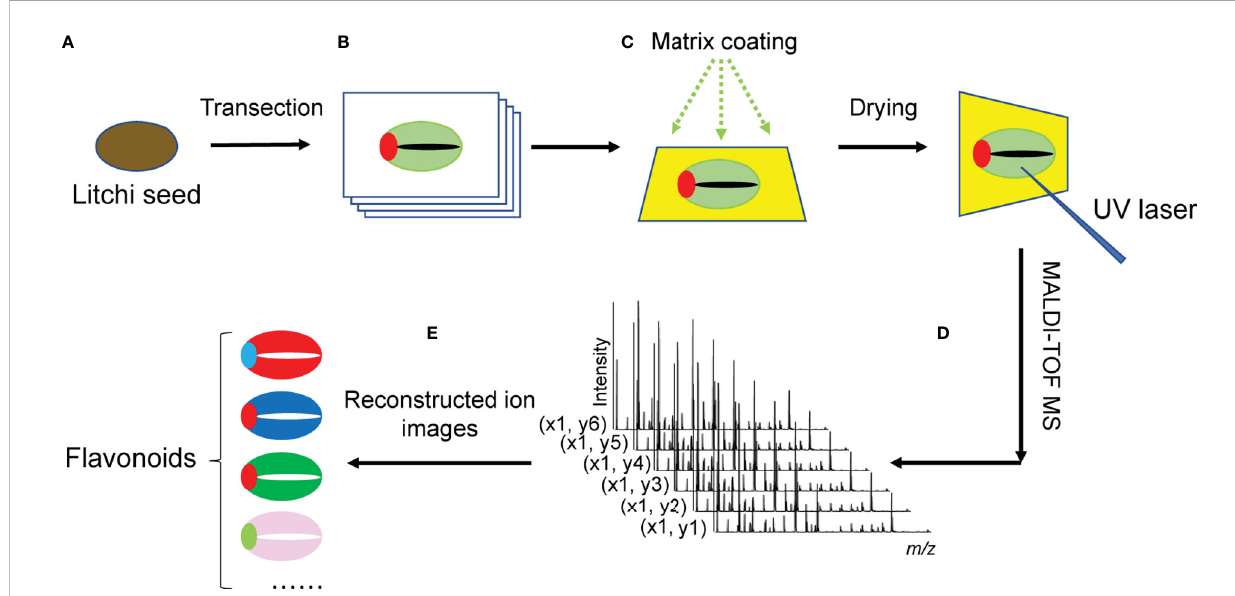
FIGURE 1 Schematic diagram of MALDI-MSI procedure for imaging fl avonoids in litchi seeds. (A) Whole litchi seeds were used for transection into 12- m m-thick slices in a cryostat microtome. (B) Serial tissue sections were immediately thaw-mounted on the conductive sides of indium tin oxide (ITO)-coated microscope glass slides. Optical images of the litchi seed section were obtained using a scanner. (C) To assist ionization, the sections were coated with the organic matrix. (D) MALDI-TOF-MS was used to detect analytes in situ on the surface of litchi seed tissue sections. The mass spectra of ionized analytes were acquired at each detected pixel point. (E) MS images of analytes were reconstructed from the MS spectra obtained at each laser spot using speci fi c imaging reconstruction software. MALDI-MSI, matrix-assisted laser desorption/ionization mass spectrometry imaging; TOF, time of fi ght; MS, mass